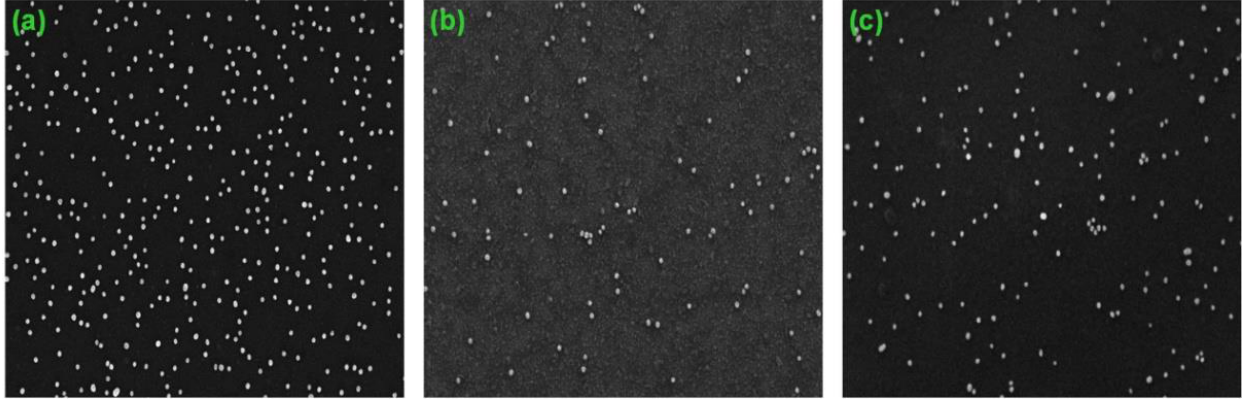
Figure 4. SEM images of the specific spots after hybridization of the microchip with 0.8 nM ( a ) and 60 pM ( b ) target DNA, containing blaCTX-M-3, and 60 pM target oligonucleotide Probe C ( c